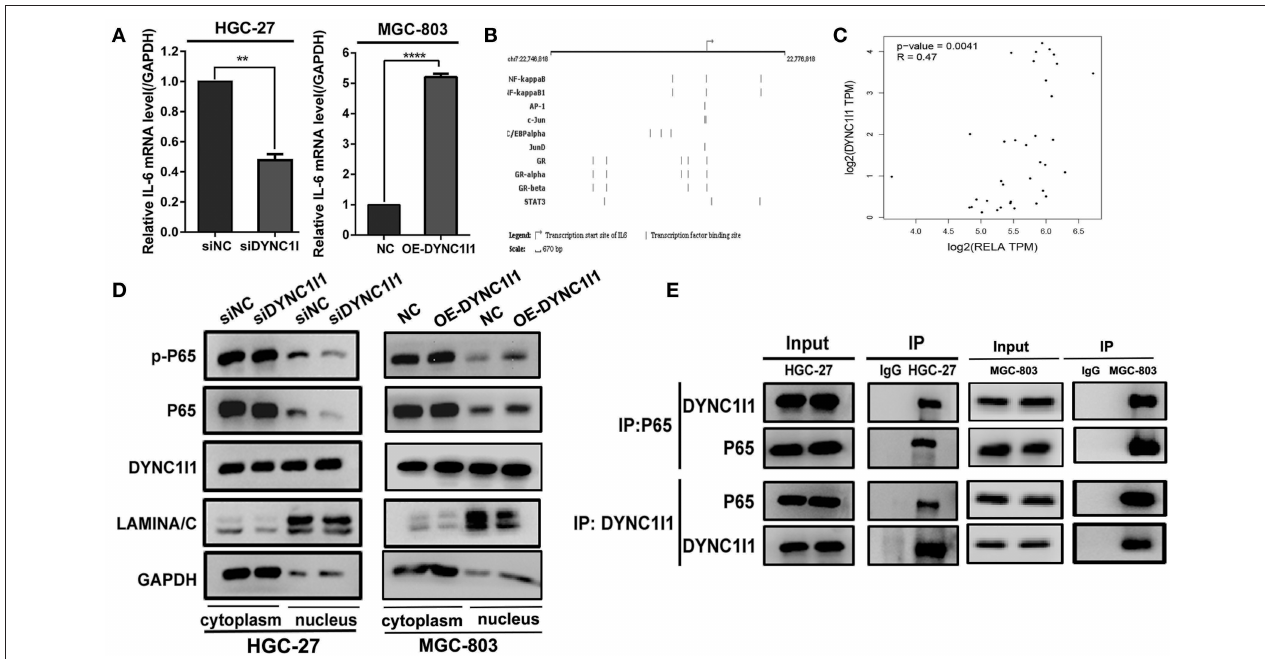
FIGURE 7 | DYNC1I1 regulates IL-6 expression by promoting NF-KB nuclear transport. (A) RT-qPCR shows IL-6 transcription level after knocking down DYNC1I1 gene or overexpression DYNC1I1. (B) Website predicts IL-6 classical transcription factor (https://www.genecards.org/). (C) GEPIA website analysis the correlation between RELA(P65) and IL-6 in gastric cancer. (D) Nucleoplasm separation shows the distribution of P65 and P-P65 in the cytoplasm after knocking down DYNC1I1 or overexpression of DYNC1I1. (E) Immunoprecipitation shows the binding of P65 to DYNC1I1 in cells. (** P < 0.01, **** P < 0.0001, n = 3, student t -test, means ± 95% CI).